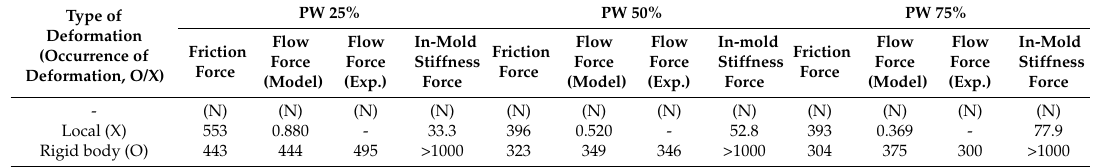
Figure 11. Change of friction and flow force with respect to flow front advancement. Arrows represent slip occurring points predicted by model and measured by experiment. ( a ) PW 25%; ( b ) PW 50%; ( c ) PW 75%. Table 4. Summary of fiber deformation and the magnitude of the related forces.